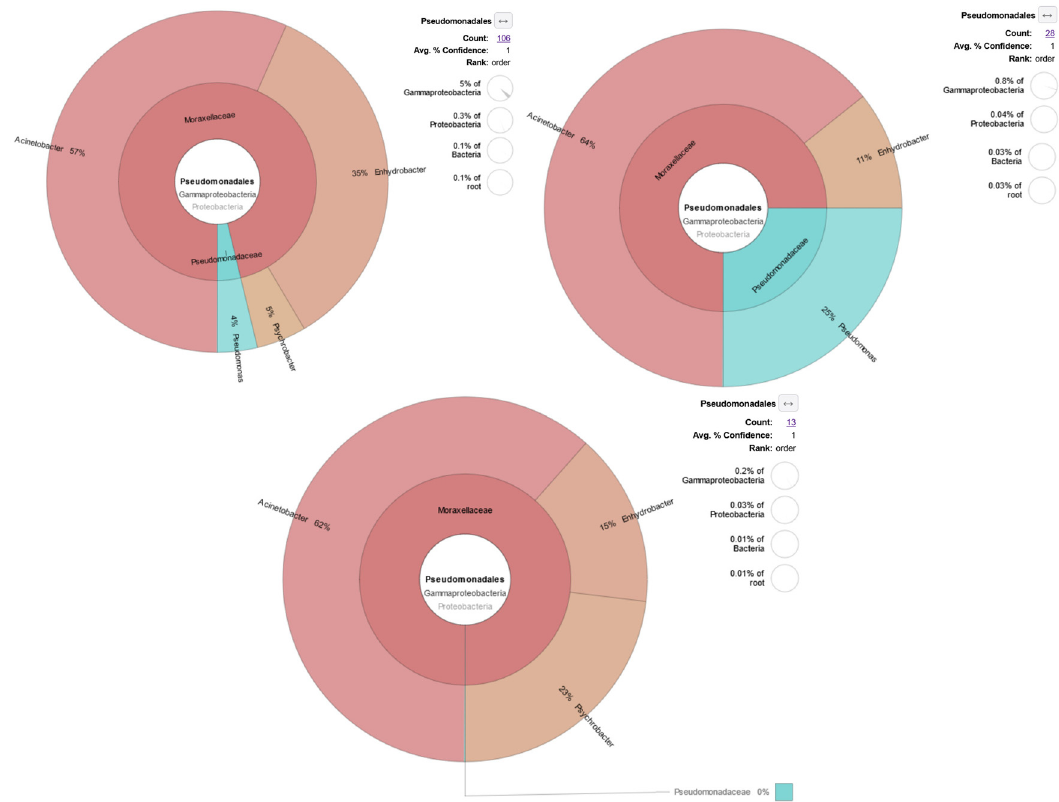
Figure 6: KRONA visually displays the analysis result of taxonomic annotation. Circles from inside to outside stand for di ff erent taxonomic ranks, and the area of the sector means the respective proportion of di ff erent OTU annotation results. The image depicts the number and proportion of Pseudomonas in the GI tract of white shrimps. Each fi gure represents sampling locations ( P1 is pond 1, P2 is pond 2, and P3 is pond 3 ) . Each fi gure consists of 10 pooled shrimp